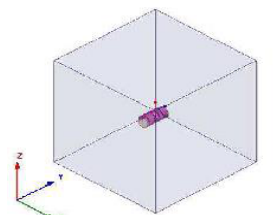
Figure 2. Cubic model used to design the ingestible antenna.